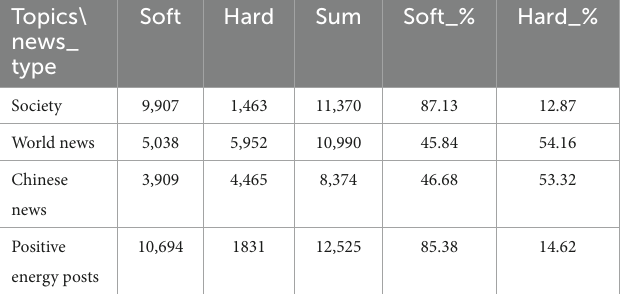
TABLE 4 Correlation between hard and soft news and topics ( p < 0.001; significant correlation with chi-square contingency on news type by post